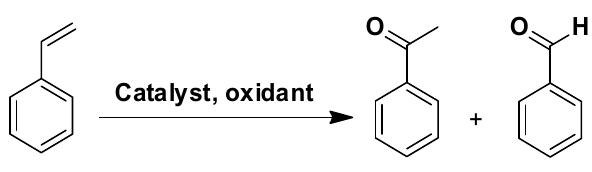
Figure 5. ( a ) Crystal packing of [Cd 1.25 (Pd − H 1.5 T p CPP)-(H 2 O)]·2DMF viewed along the [1,1,0] direction,